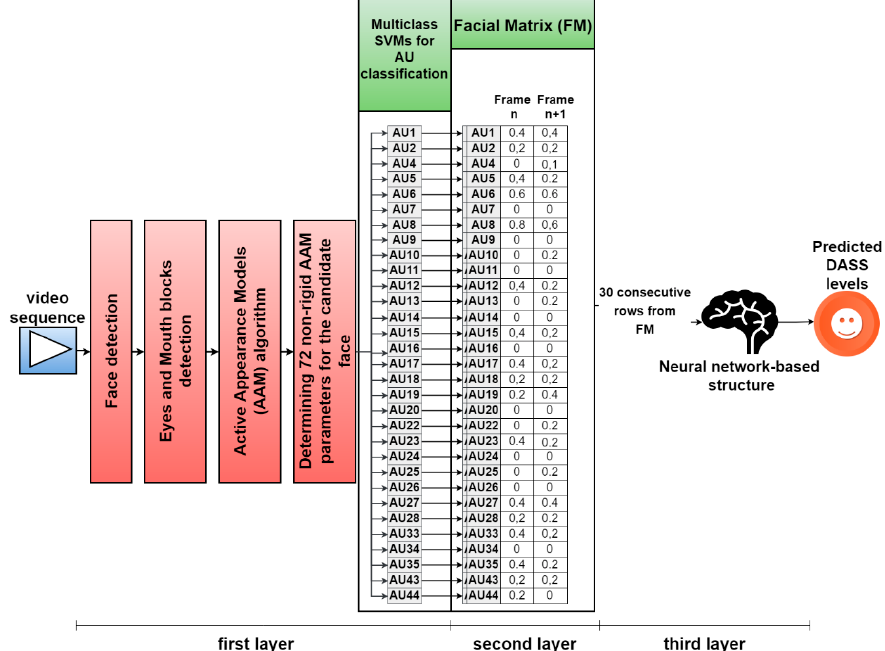
Figure 4. Overall architecture for predicting DASS levels by analyzing facial features using FACS.